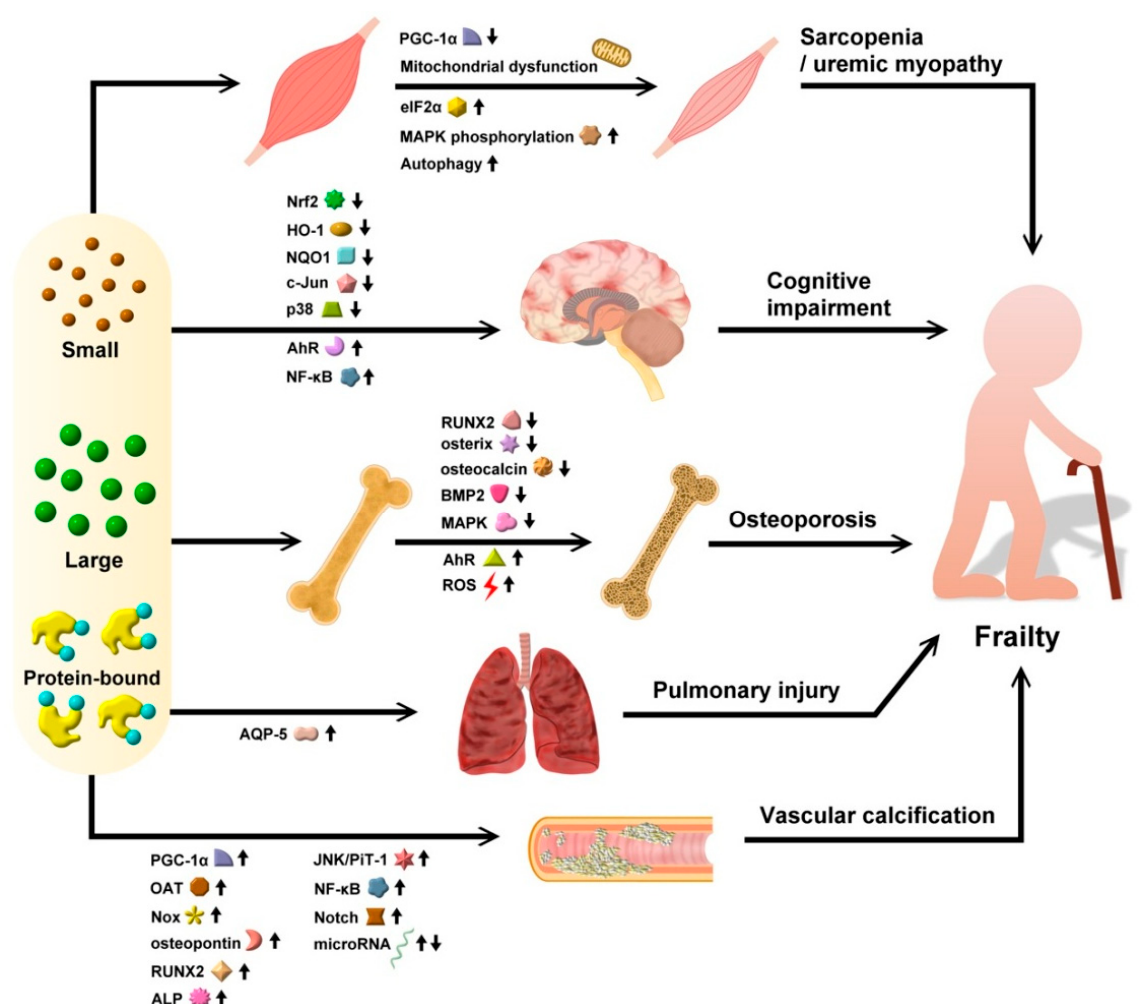
Figure 2. A summary diagram illustrating the putative organ-wide pathogenic relationship between UTs and frailty in patients with CKD. Upward arrows indicate up-regulation, while downward arrows indicate down-regulation. AhR, aryl hydrocarbon receptor; ALP, alkaline phosphatase; AQP, aquaporin; BMP2, bone morphogenic protein 2; CKD, chronic kidney disease; eIF2 α , eukaryotic initiation factor 2 α ; HO-1, heme oxygenase-1; JNK, c-Jun N-terminal kinase; MAPK, mitogen activated protein kinase; NF- κ B, nuclear factor- κ B; Nox, NADPH oxidase; NQO1, NADPH dehydrogenase quinone 1; Nrf2, nuclear factor erythroid 2-related factor 2; OAT, organic acid transporter; PGC-1 α , peroxisome proliferator-activated receptor γ coactivator 1- α ; PiT-1, phosphate inorganic transporter 1; ROS, reactive oxygen species; RUNX2, Runt-related transcription factor 2